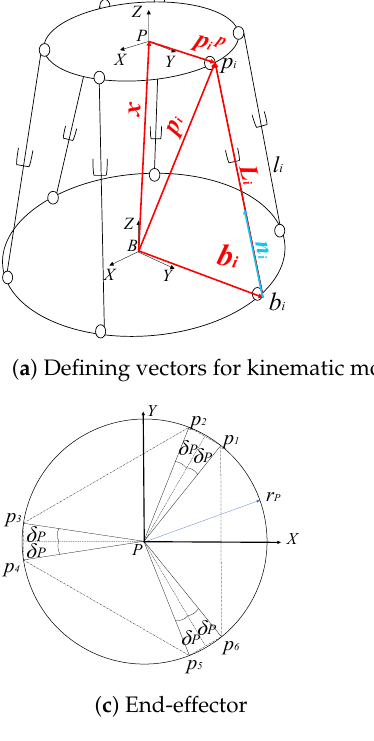
Figure 2. General Universal-Prismatic-Spherical (UPS) Gough-Stewart structure. Stage 1 looks for the optimal r B , r P , δ B , δ P , and maximum stroke l max to cover a dexterous workspace. Stage 2 uses the resulting geometry to provide an optimal dynamic